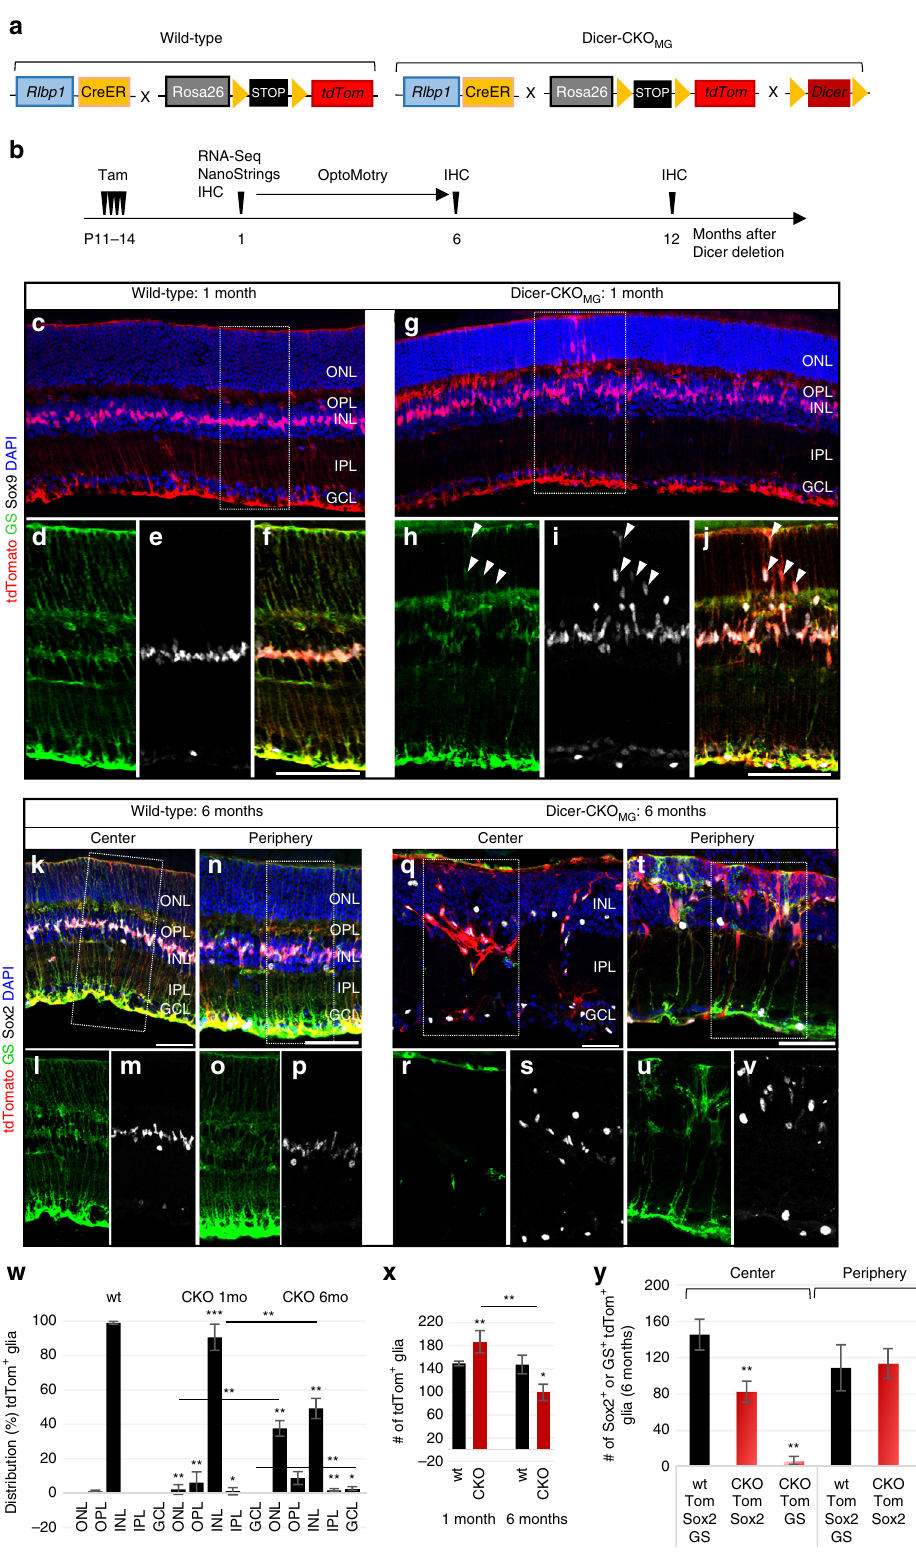
Wild-type: 6 months Dicer-CKO MG :